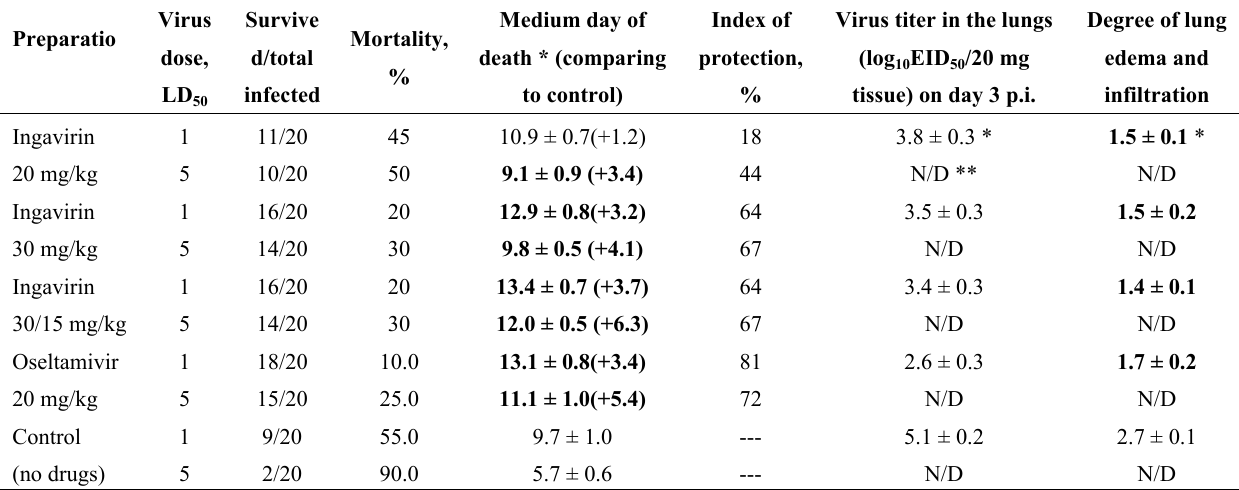
Table 1. Protective activity of Ingavirin against influenza A (H1N1) 2009. p < 0.05 values are indicated in bold.